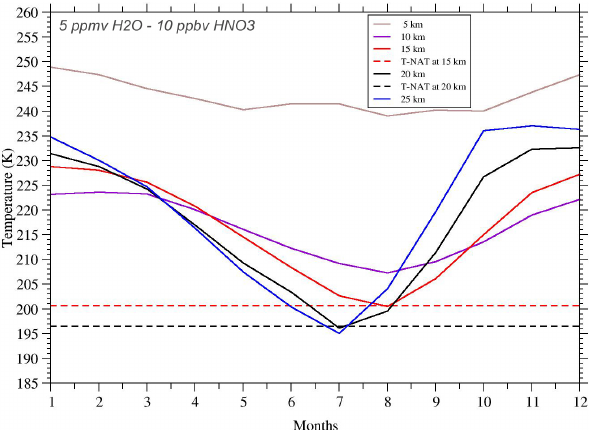
Fig. 7. Mean annual cycle in temperature for different altitude lev- els (5, 10, 15, 20 and 25km) for the 1979-2008 period at Dumont d’Urville; NAT threshold temperatures are shown for 5ppmv H 2 O and 10ppbv HNO 3 vapor contents at 15 and 20km (dashed lines).